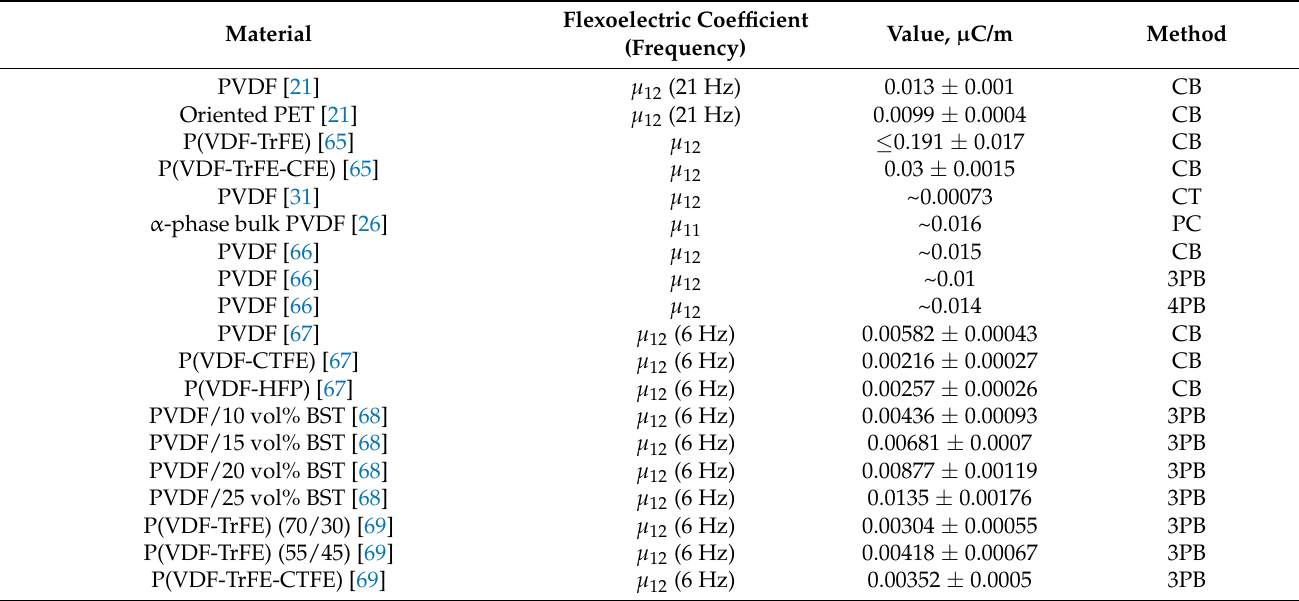
Table 3. Summary of the measured flexoelectric coefficients of ferroelectric polymers at room